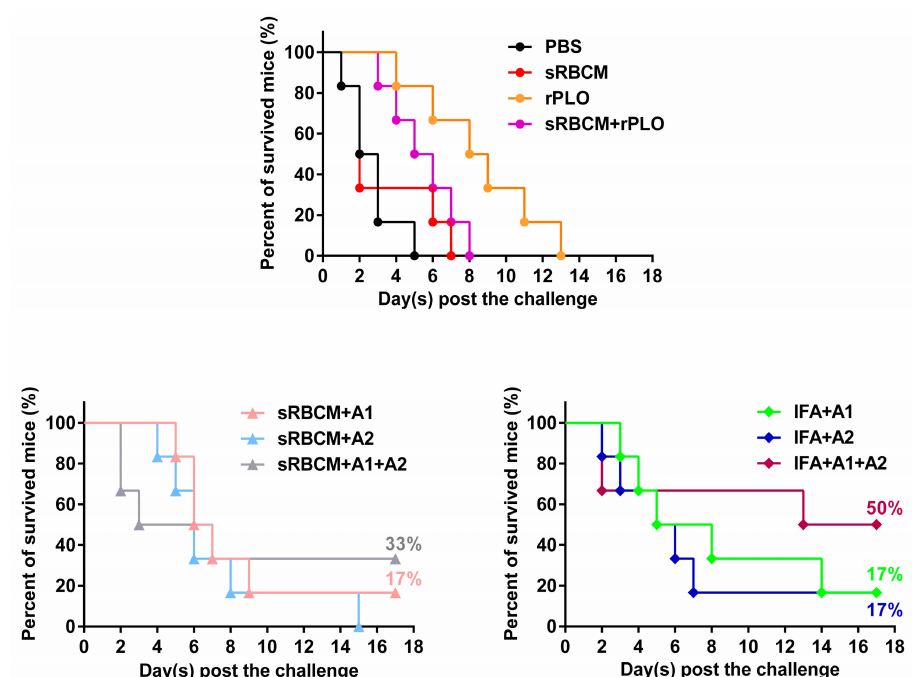
Figure 6. Survival curve of mice after the lethal challenge with Trueperella pyogenes ( T. pyogenes ). A total of 50% of the mice that received the IFA emulsified tPLOA1 (A1) + tPLOA2 (A2) survived the challenge. Moreover, 33% of the mice that received the sRBCM-trapped tPLOA1 + tPLOA2 survived the challenge. Furthermore, 17% of the mice that received IFA emulsified tPLOA1 or tPLOA2 and the mice that received sRBCM-trapped tPLOA1 survived the challenge. The mice in other groups died within 15 days after the